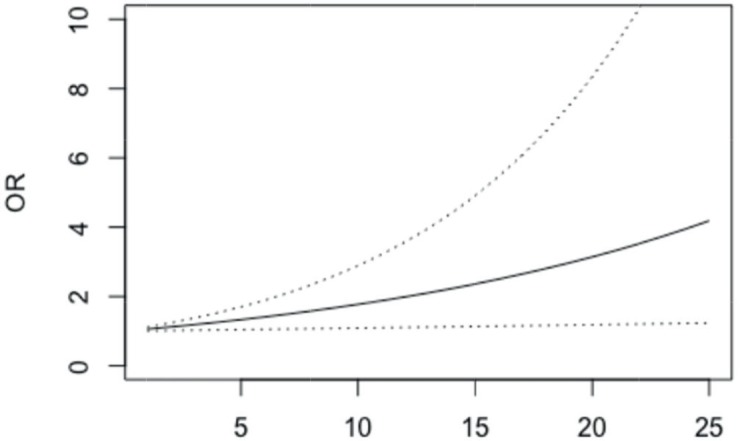
OR of not having depression in patients with differences in the BRBI scale scores between 1 and 25 points (95% confidence bands for the OR are shown in dash lines).